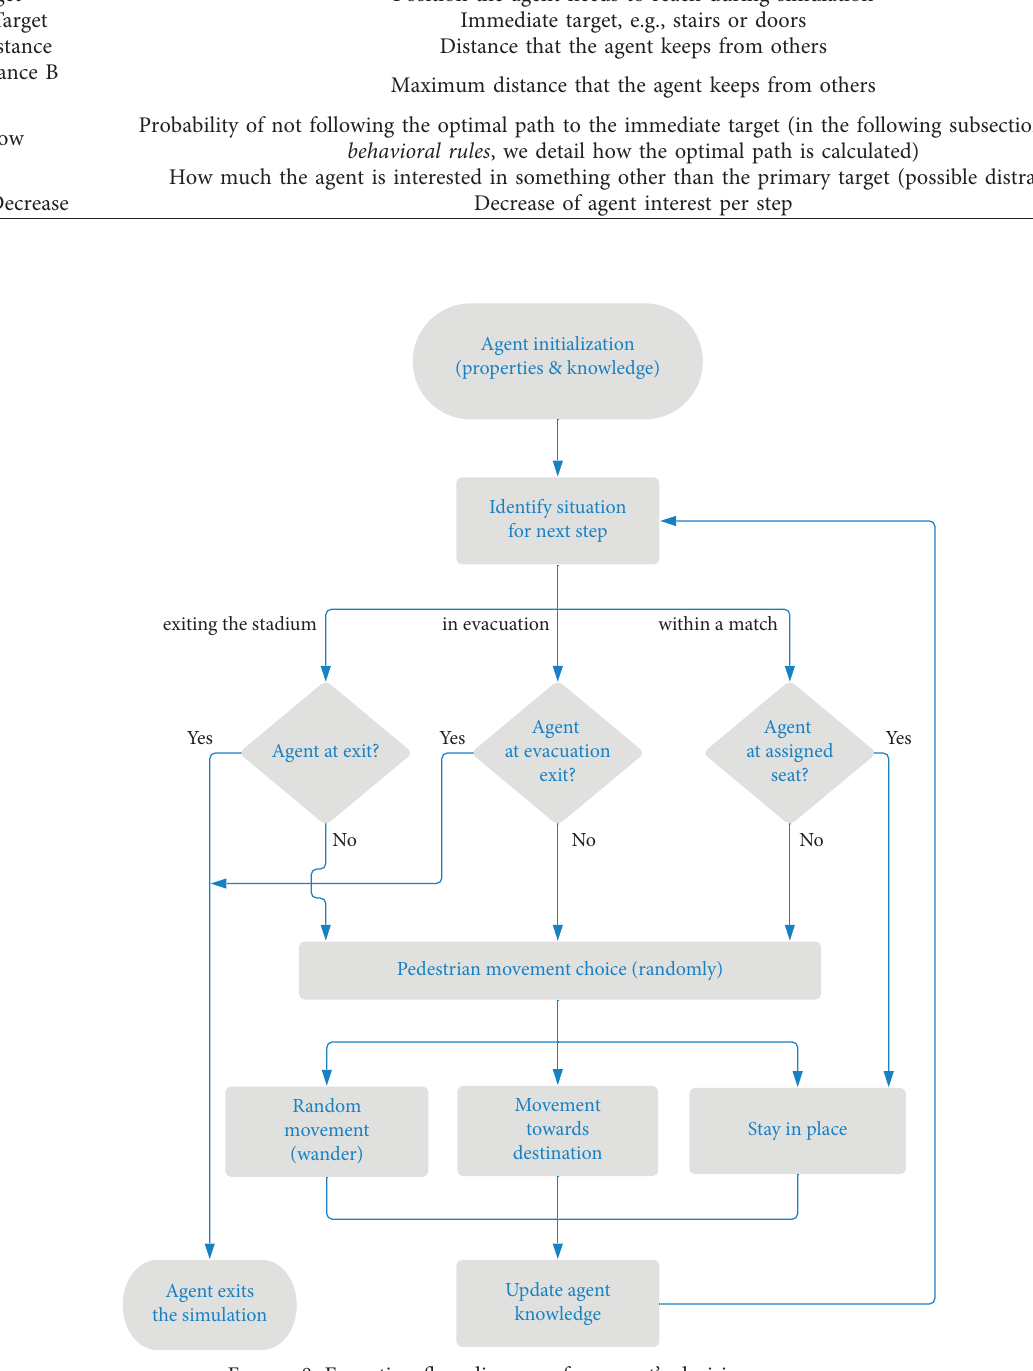
Figure 8: Execution flow diagram of an agent’s decision